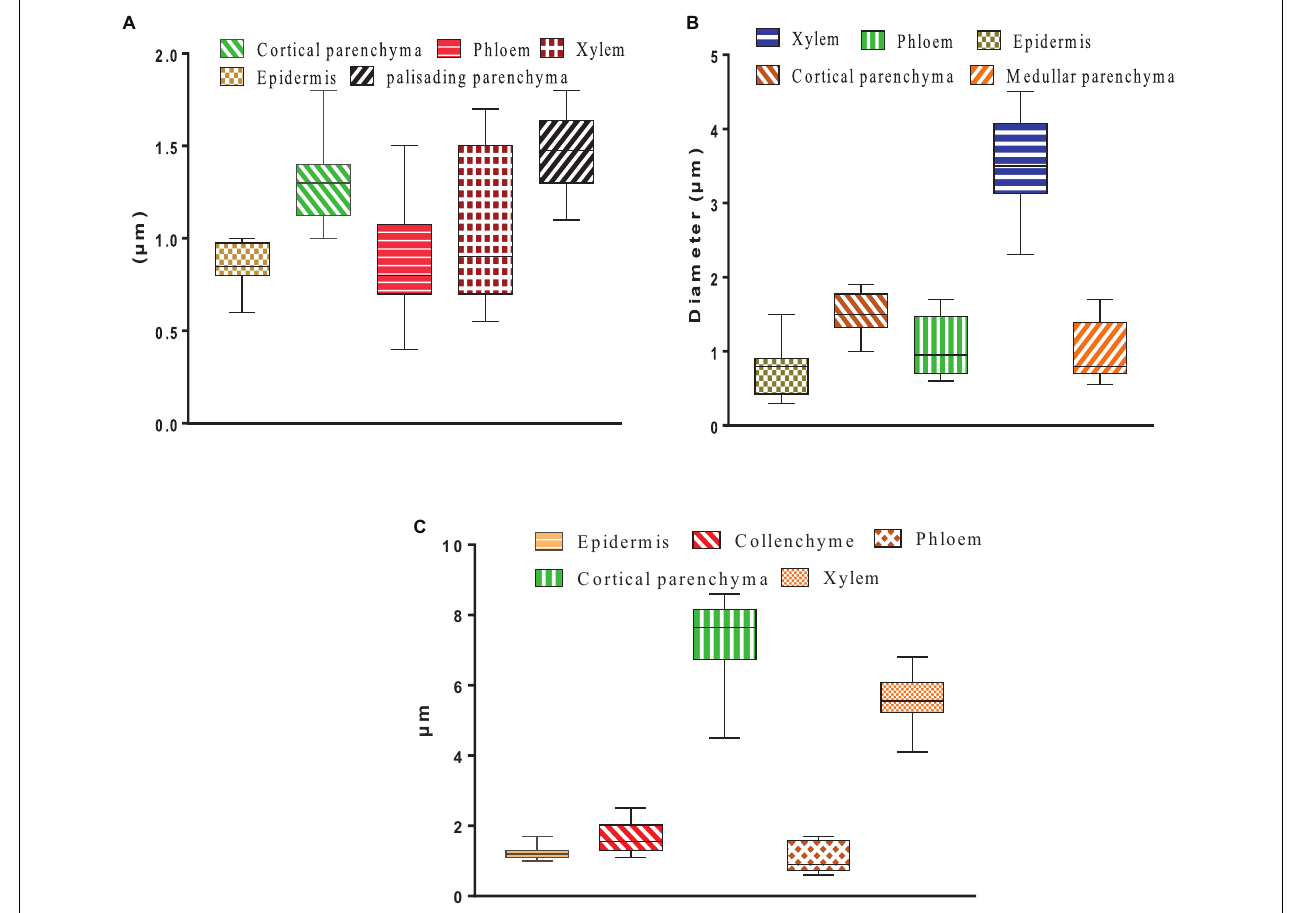
FIGURE 6 | (A) Leaf tissue thickness. (B) Histometry of root cross sections. (C) Histometry of stem cross sections of Withania frutescens (L.) Pauquy.